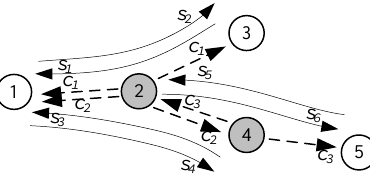
Figure 3. Network coding opportunity in intermediate nodes.